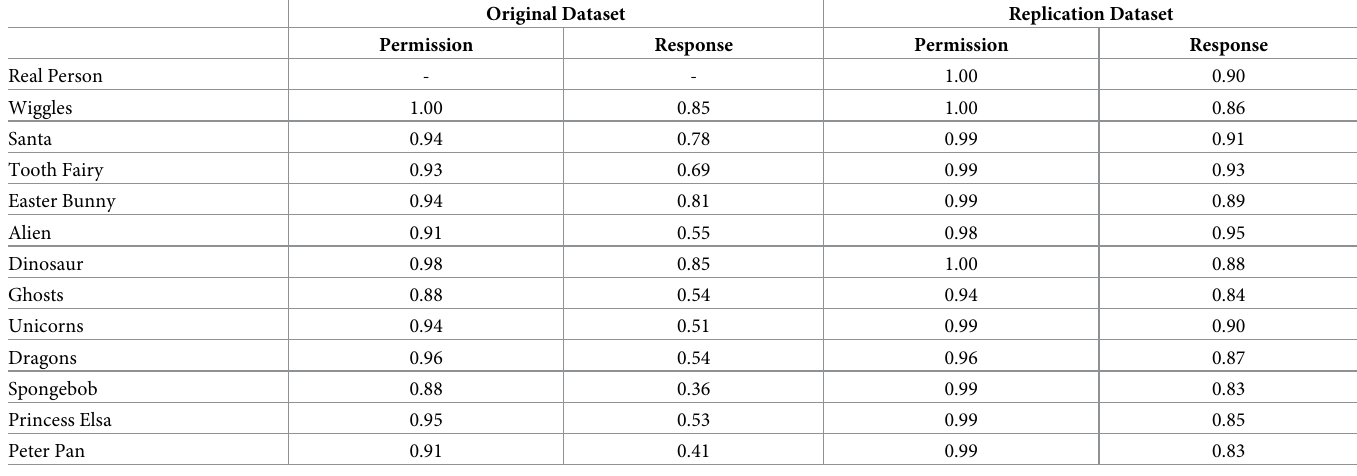
Table 5. The proportion of children for whom permission was granted for each figure (in each dataset), and the proportion thereof who subsequently provided endorsement